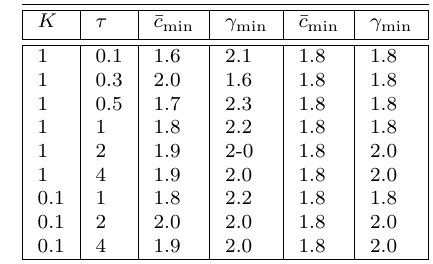
Table 1: PID controller, Eq. (26), with the pro- posed δ -tuning rules in Alg. 2.1 and Eq. (27) for a DIPTD process, h p ( s ) = K e − τs with varying gain, K , and time-delay, τ . Shows ¯ c min , γ min = arg min ¯ c,γ IAE vu , with prescribed δ = 1 . 6 (columns 3 and 4) and δ = 3 . 5 (columns 5 and 6).